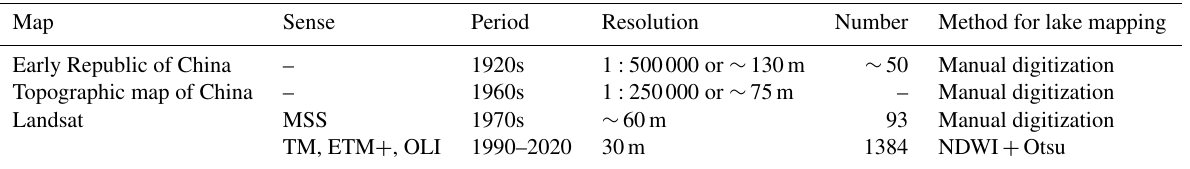
Table 1. Maps (images) and methods used for lake mapping from 1920 to 2020. Map Sense Period Resolution Number Method for lake mapping – 1920s 1 : 500000 or ∼ 130m ∼ 50 Manual digitization Topographic map of China – 1960s 1 : 250000 or ∼ 75m – Manual digitization Landsat MSS